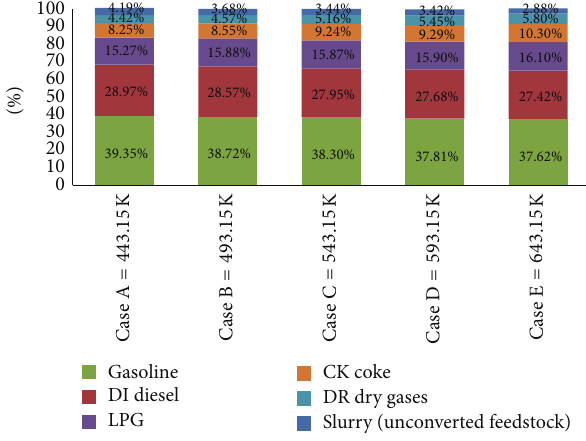
Figure 10: Products yields for each feedstock